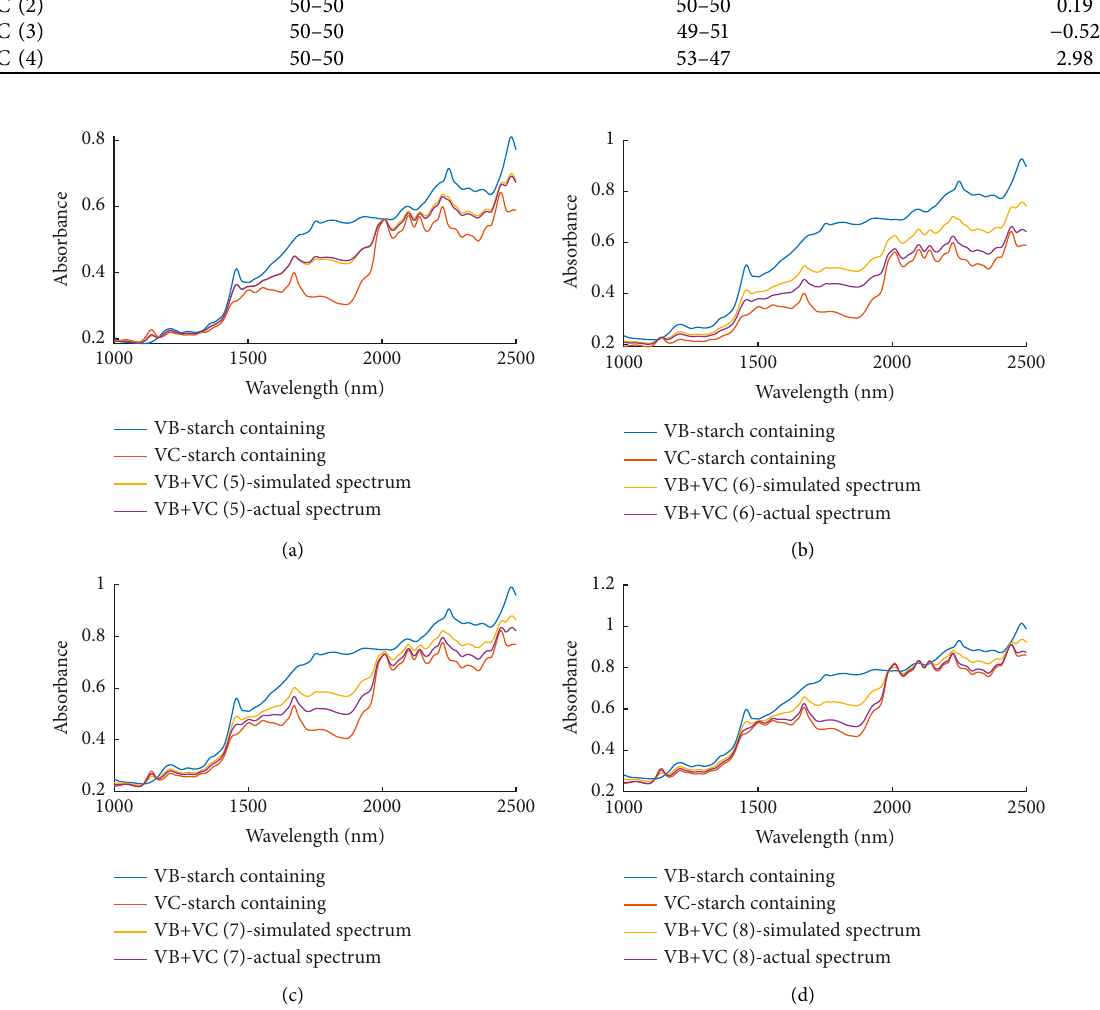
Table 4: Analytic percentage, actual percentage, and the error between them of the vitamin samples VB +VC (1) Actual percentage (/%) Analytic percentage (/%) Absolute error (/%) VB +VC (1)